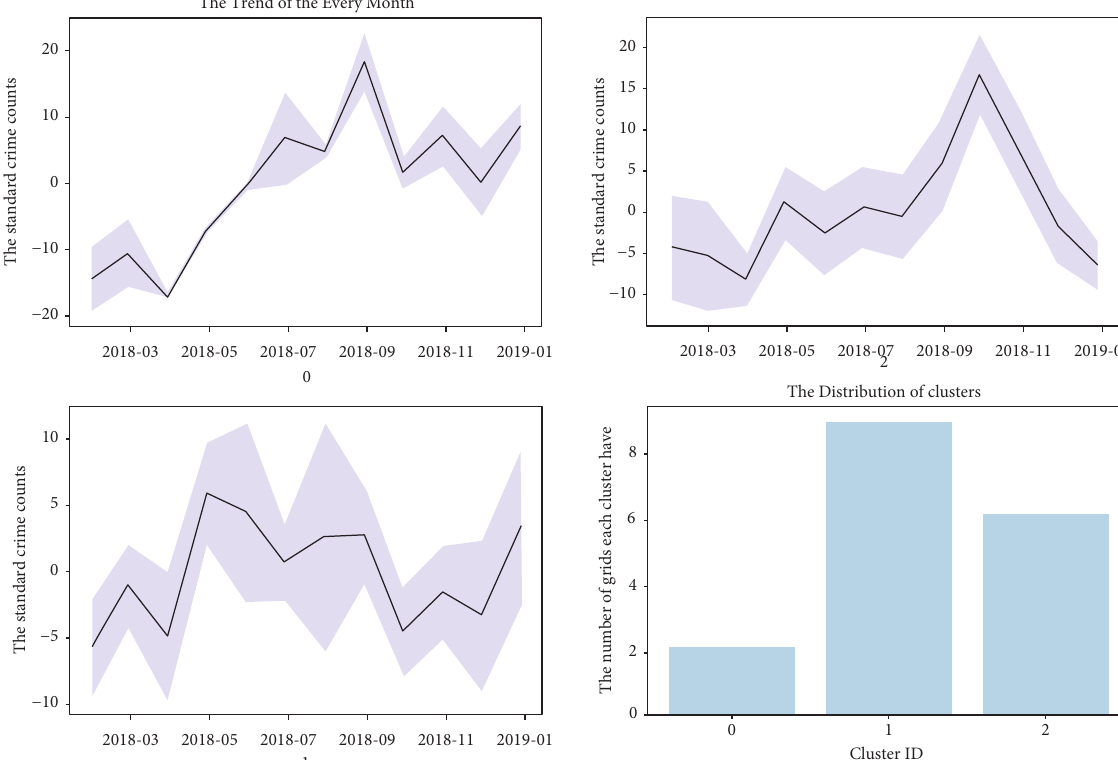
Figure 15: The theft in Philadelphia trends in each month in 2018 and the distribution of clusters. The line charts are the monthly trends of theft in Philadelphia in 2018. The bar chart is the distribution of the clusters.